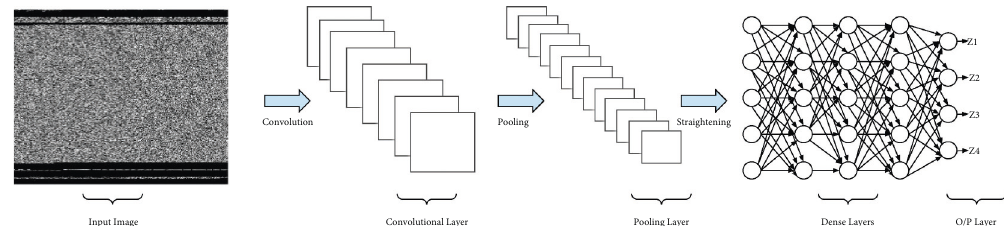
Figure 5: CNN model